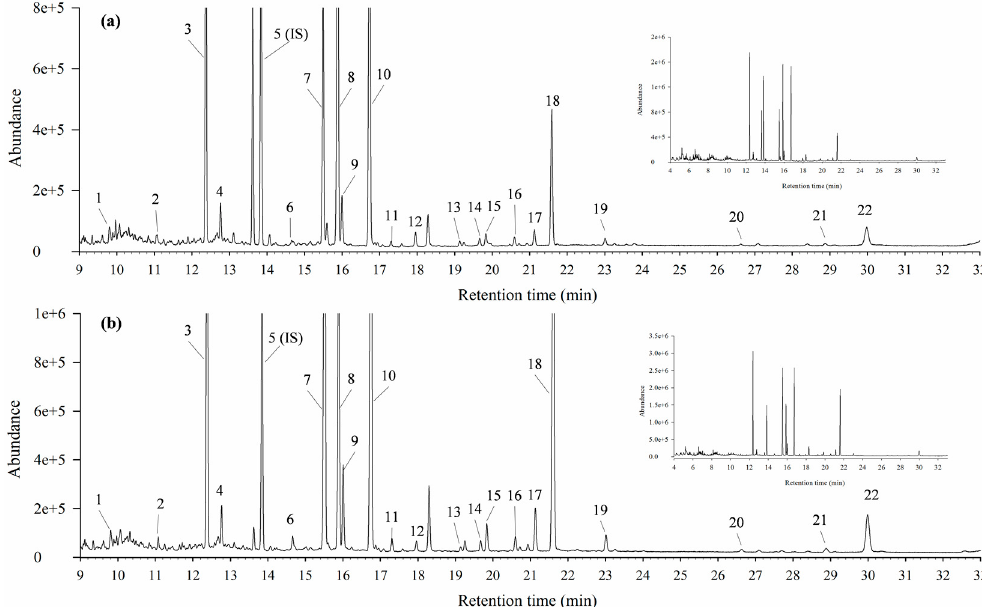
Figure 5. Typical total ion chromatograms of rat serums from HCD group by gas chromatography–mass spectrometry (GC-MS): ( a ) free fatty acids (FFAs) and ( b ) esterified fatty acids (EFAs). IS, internal standard. For the multivariate analysis using PLS-DA, VIP was chosen to find out those peaks in GC-MS